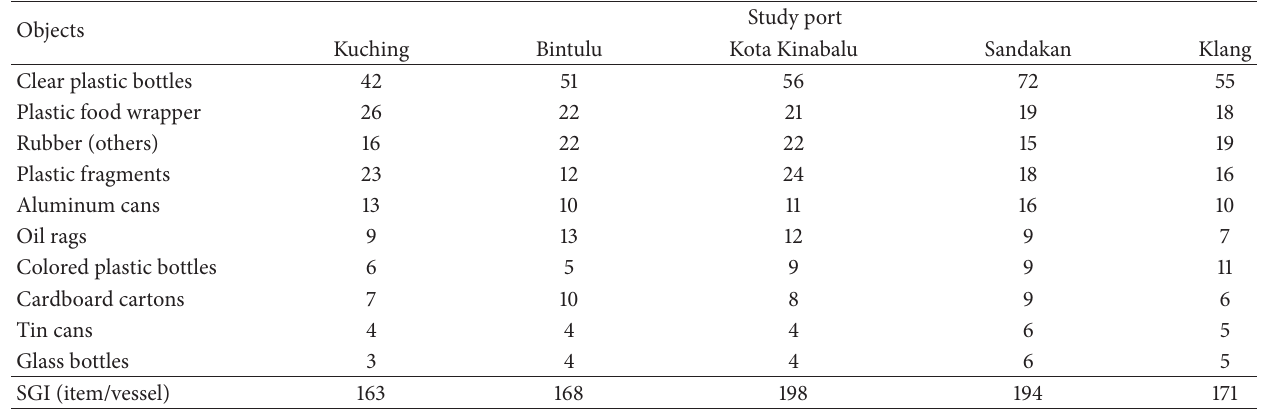
Table 4: Ten most numerous objects (item/vessel) found and SGI at the study